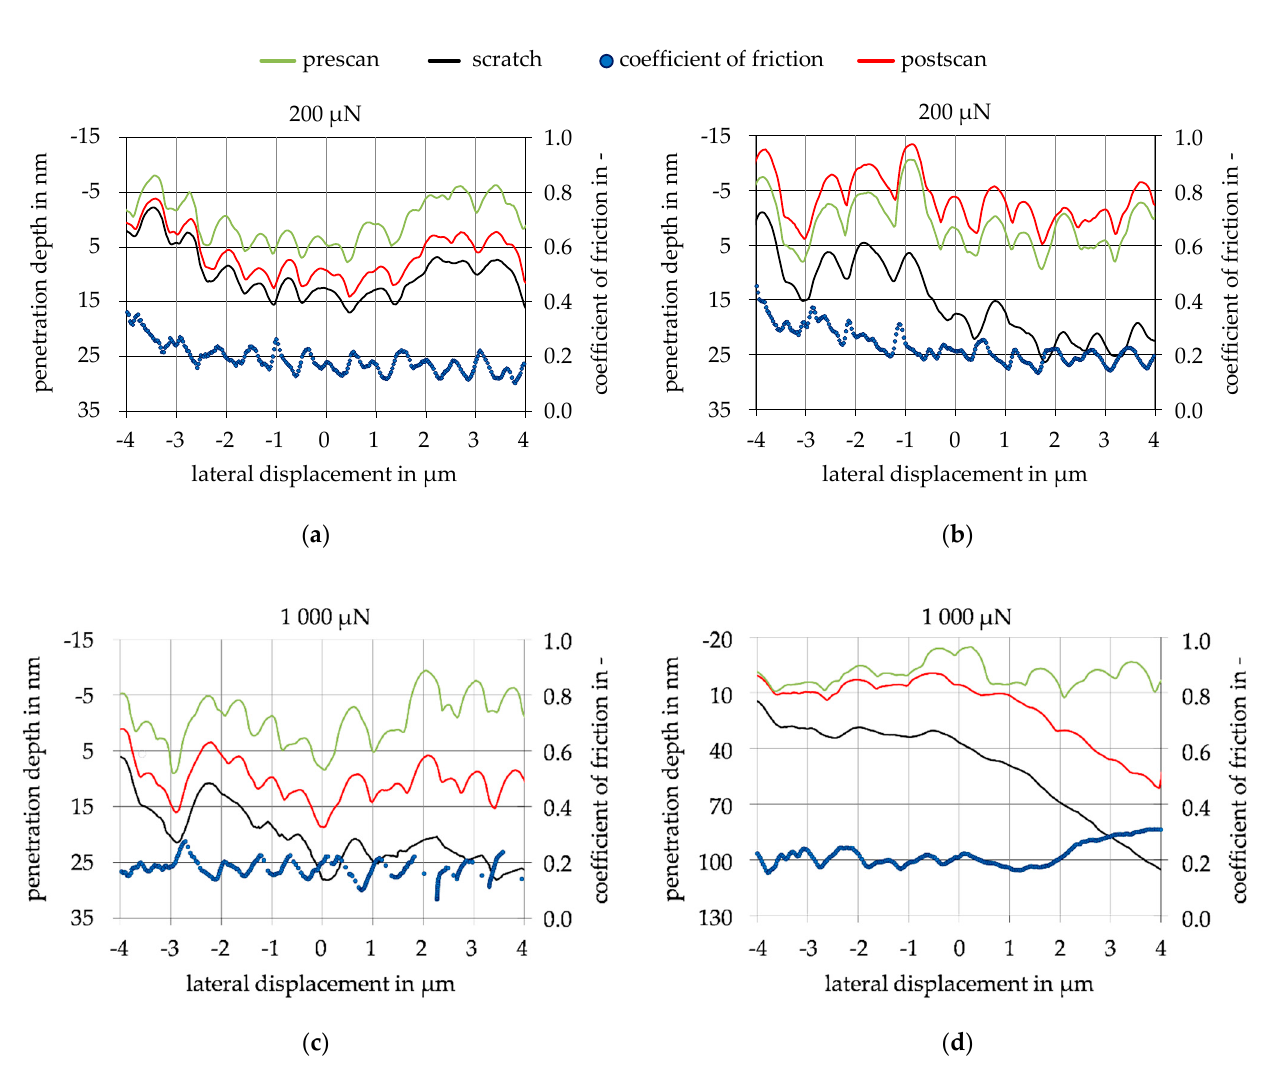
Figure 10. Resulting penetration depth of pre ‐ scan, scratch, post ‐ scan, and coefficient of friction: ( a ) Normal force of 200 μ N for the Mo ‐ coating; ( b ) Normal force of 200 μ N for the MoO 3 ‐ coating; ( c ) Normal force of 1000 μ N for the Mo ‐ coating; ( d ) Normal force of 1000 μ N for the MoO 3 ‐ coating.